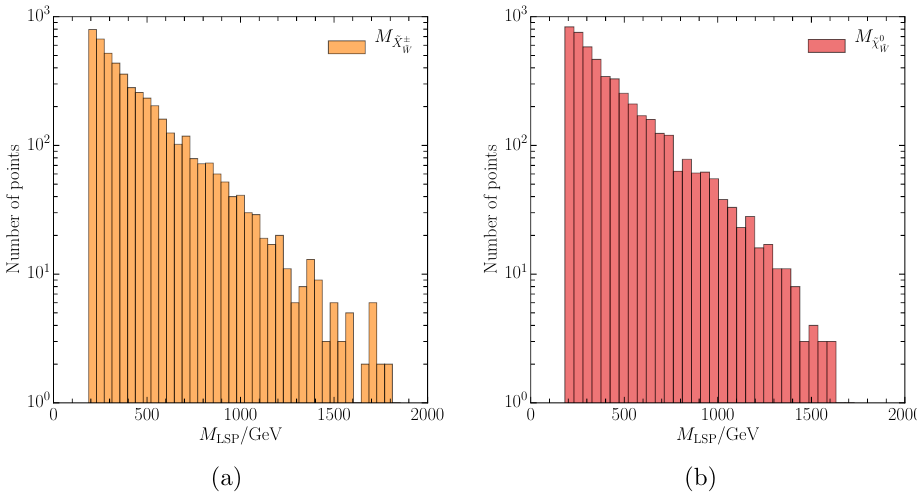
Figure 4. (a) Mass distribution of the Wino chargino LSPs. The masses range is from 194 GeV to 1710 GeV, peaking towards the low mass end. (b) Mass distribution of the Wino neutralino LSPs. The masses range is from 192 GeV to 1630 GeV, peaking towards the low mass end.